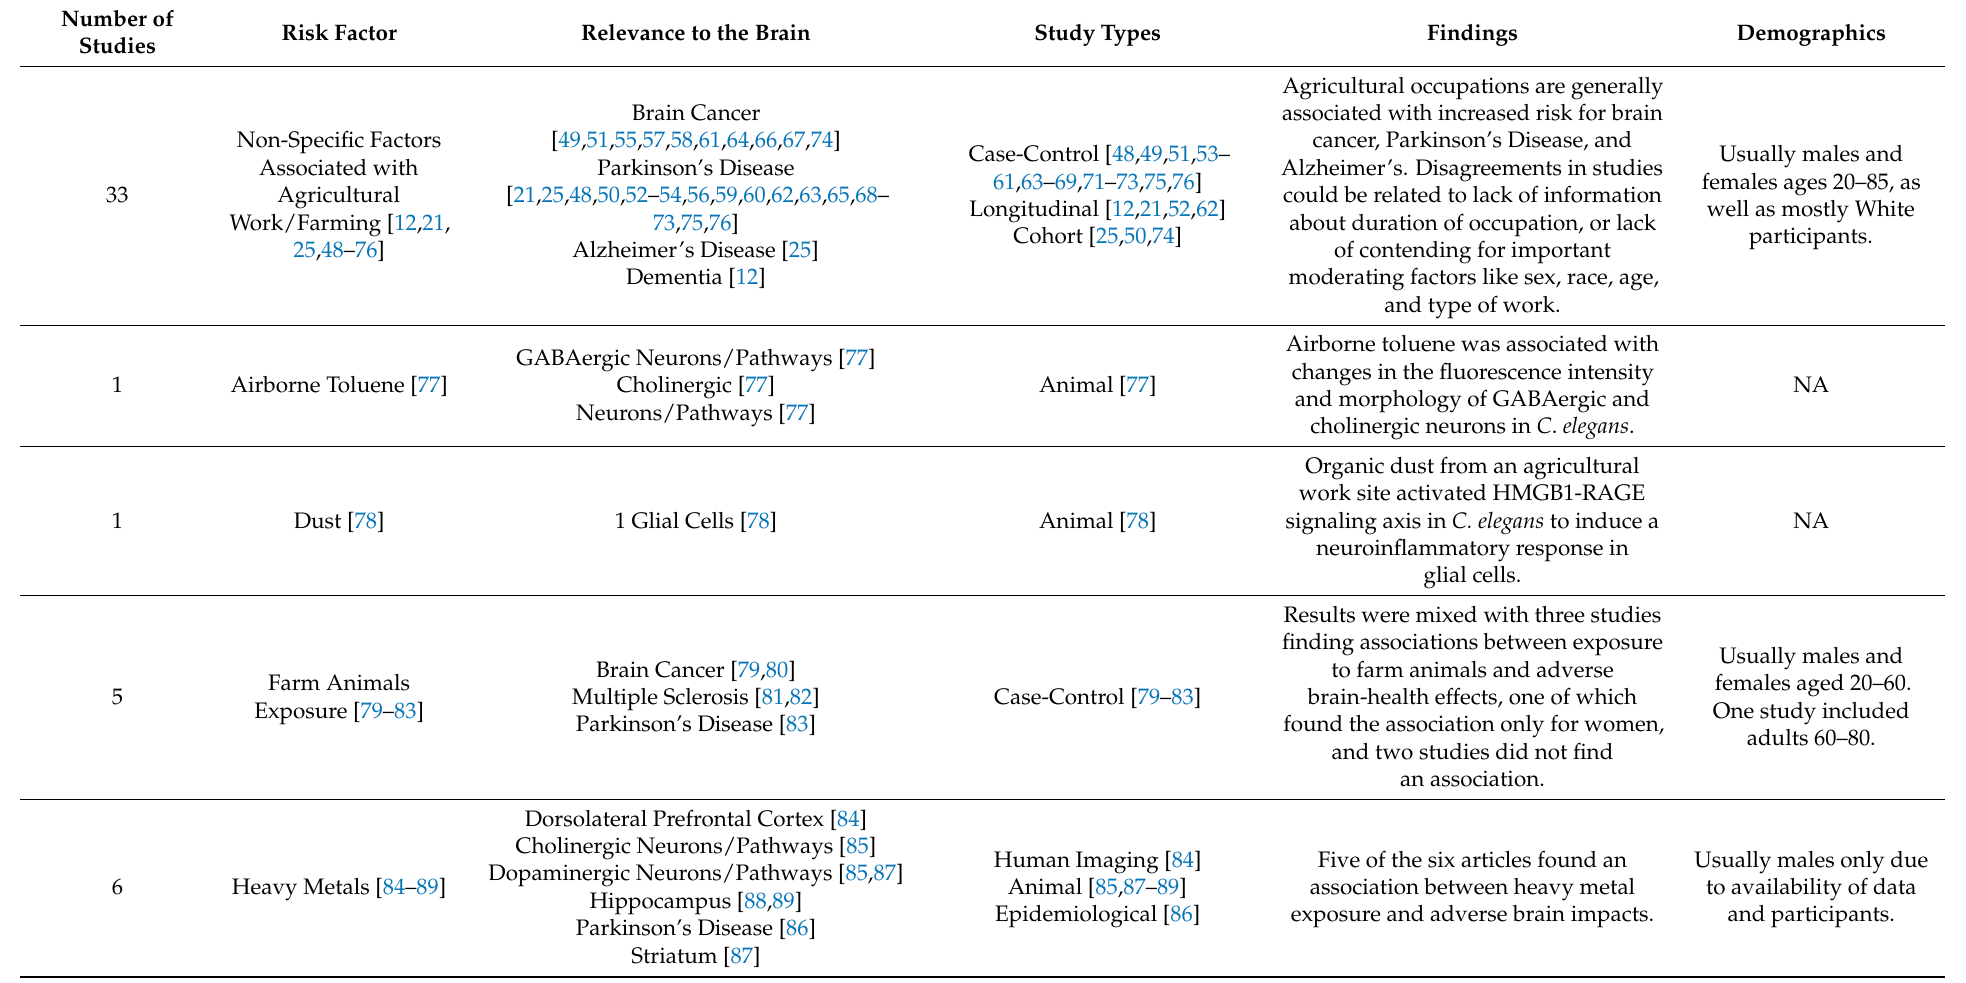
Table 1. Articles included in the review sorted by risk factor, brain area, and type of study with notes on participant